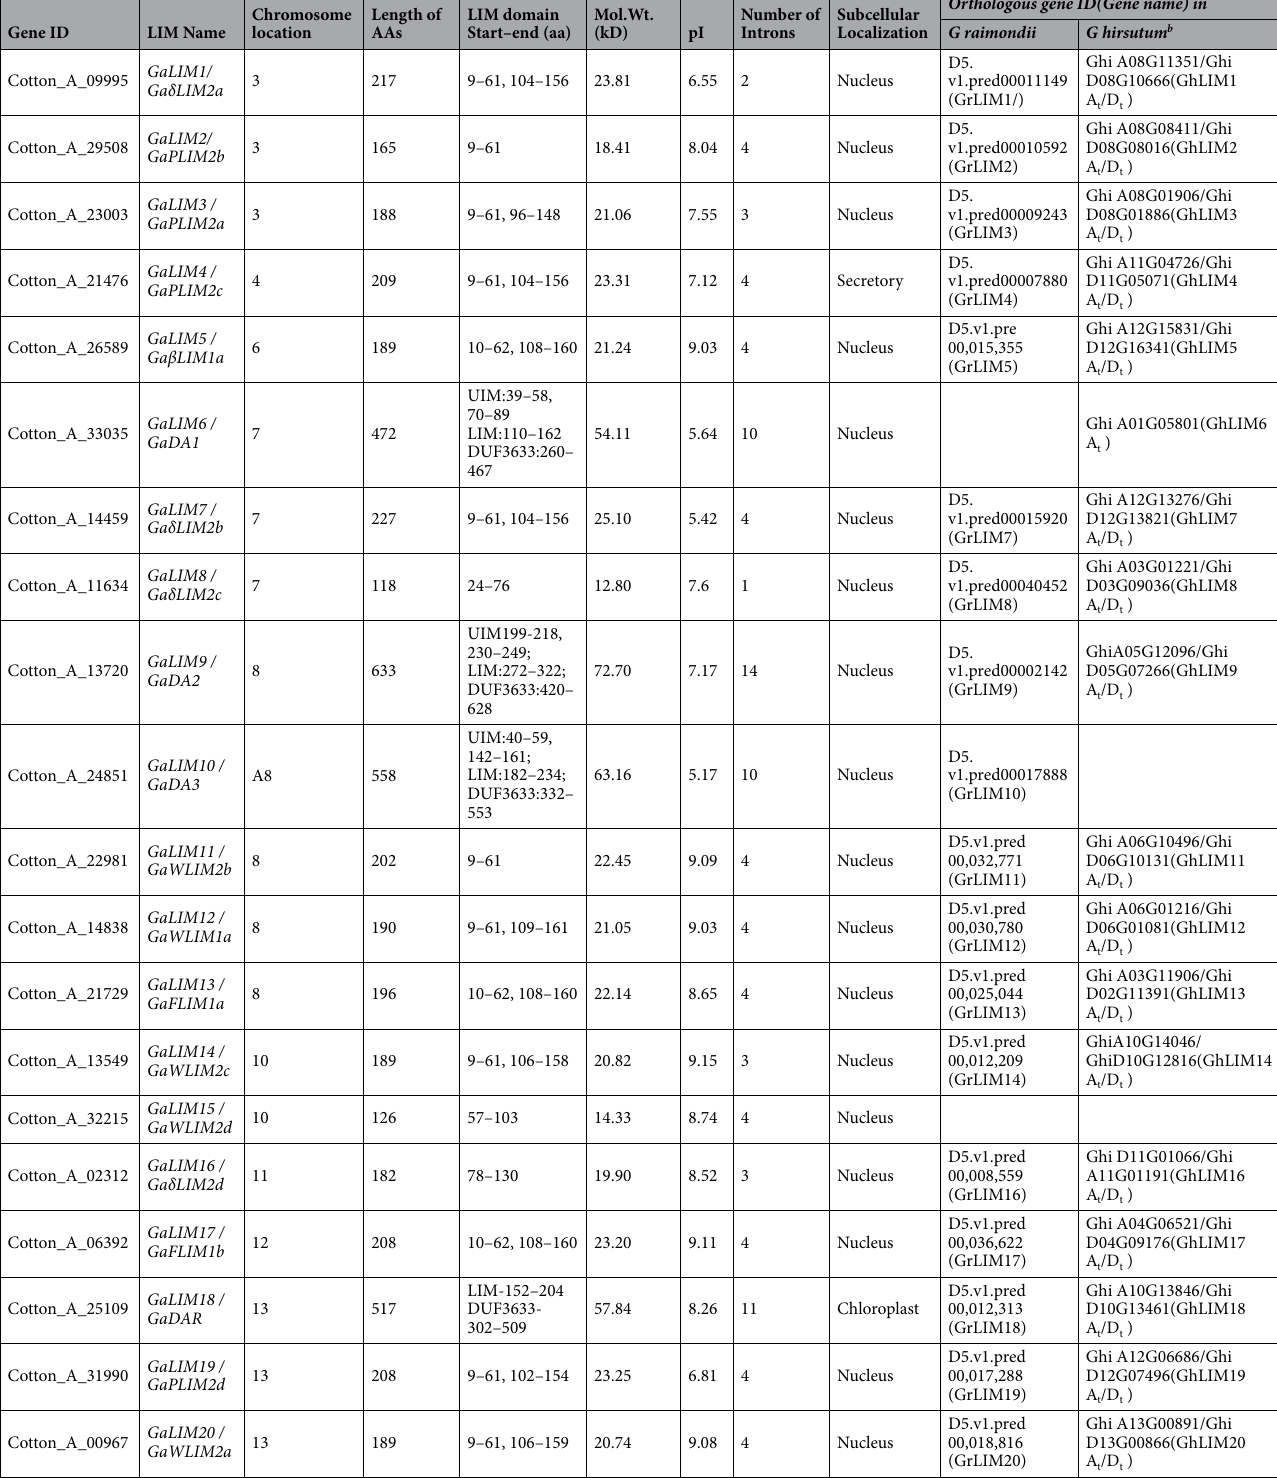
Table 1. Details of LIM family genes identified in G. arboreum and their phylogenetic relationship in G.raimondii and G .hirsutum